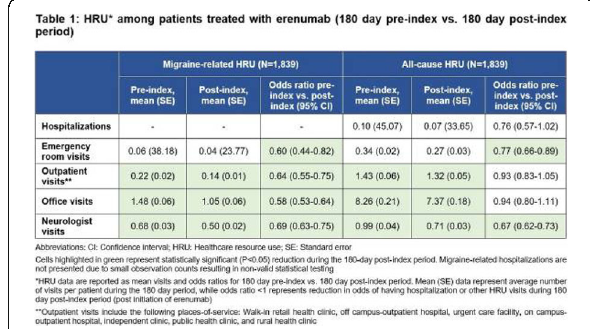
Table 1 (abstract AL050). See text for